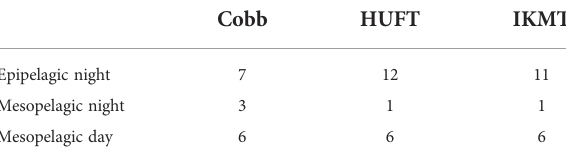
Weighted mean depths for the epipelagic and mesopelagic were 58 and 542 m,